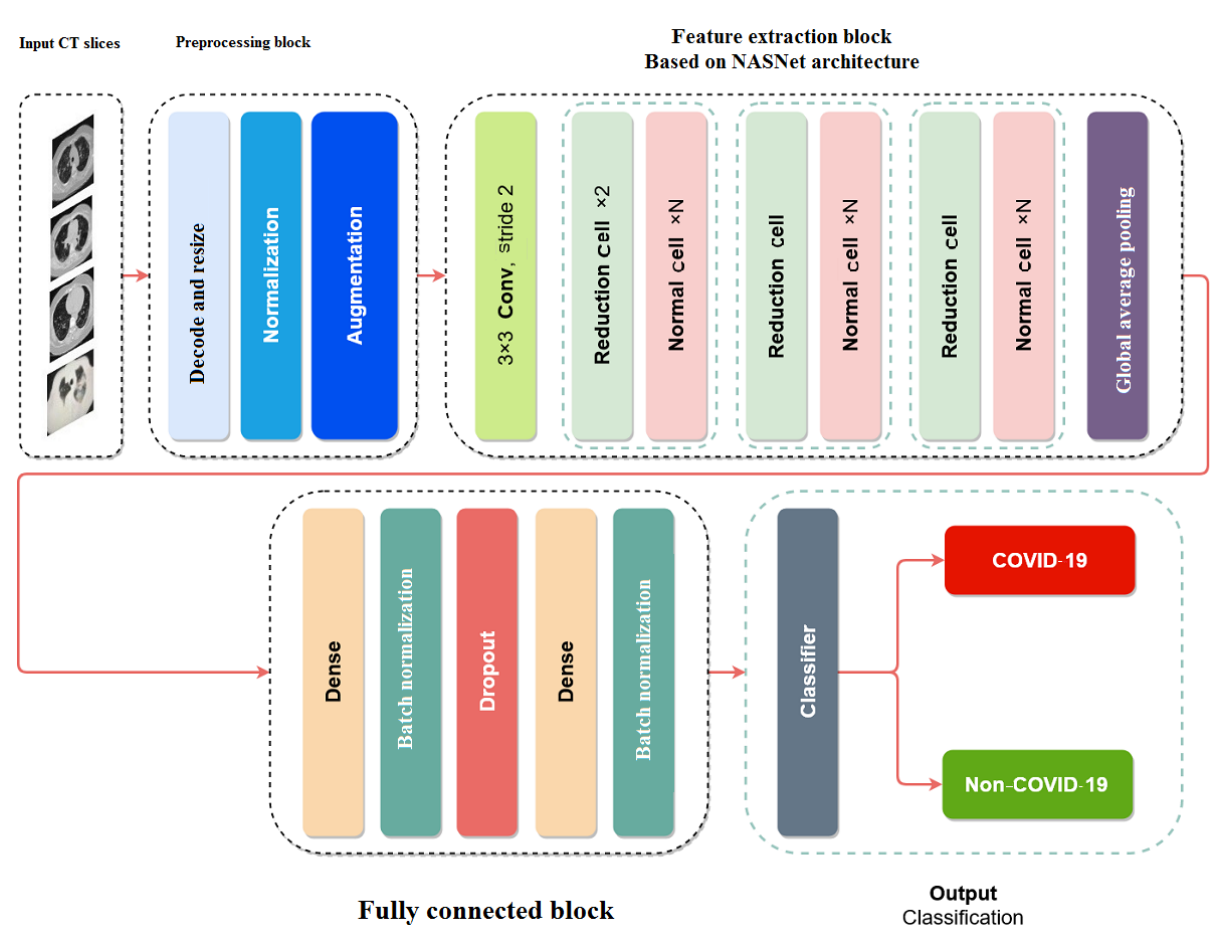
Figure 3. Proposed deep convolutional neural network–based CAD system for COVID-19 detection using multiple lung computed tomography scans. CT: computed tomography.